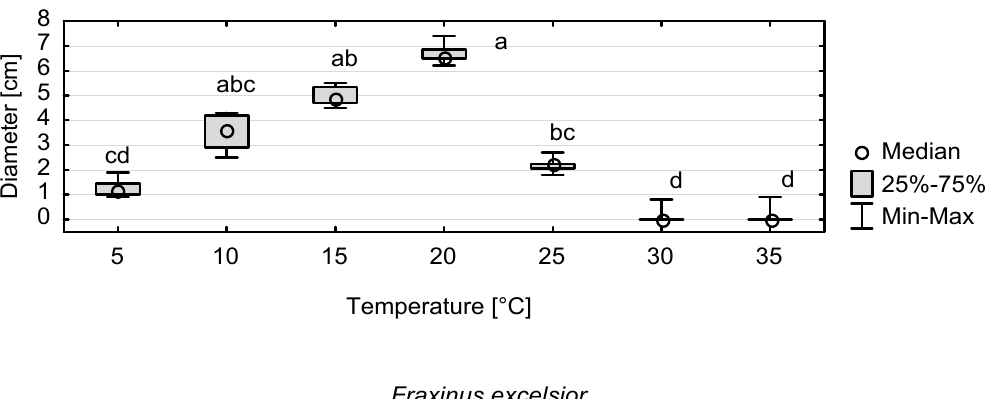
16 of 28 Figure 6. Phylogram obtained in maximum likelihood (ML) analysis of the combined ITS-ACT-CAL datasets of the Apiognomonia spp. and selected species from Gnomoniaceae. Sequences obtained in this study are marked in bold type. The bootstrap values ≥ 75% for ML and maximum parsimony (MP) analyses are presented at the nodes using ML/MP pattern. Bold branches indicate posterior probability values ≥ 0.95 obtained in Bayesian Inference (BI) analysis. * Bootstrap values < 75%. The tree is drawn to scale (see bar) with branch length measured in the number of substitutions per site. Cryphonectria parasitica 1155-2 represents the outgroup. The abbreviations used after the semicolon indicate the host plants for isolates: Ah— Aesculus hippocastanum , Ap— Acer pseudoplatanus , Cd— Castanea dentata , Cn— Cornus nuttallii , Fe— Fraxinus excelsior , Fs— Fagus sylvatica , Po— Platanus occi- dentalis , Pxa— Platanus × acerifolia , Q— Quercus sp., Qa— Quercus alba , Qr— Quercus robur , Tc— Tilia cordata . In the three-gene phylogeny, the most prominent clade within the Apiognomonia group contains two subclades, separating A. errabunda and A. veneta isolates. Both the A. errabunda / A. veneta clade and the A. errabunda and A. veneta subclades received very high node support values in all three phylogenetic analyses. 3.3. Apiognomonia hystrix Growth in Relation to Temperature Both F. excelsior - and A. pseudoplatanus -originating isolates of A. hystrix showed sim- ilar patterns of growth reactions at various temperatures (Figure 7). In the temperature range of 5–20 °C, the colony diameter increased with temperature, but the differences be-